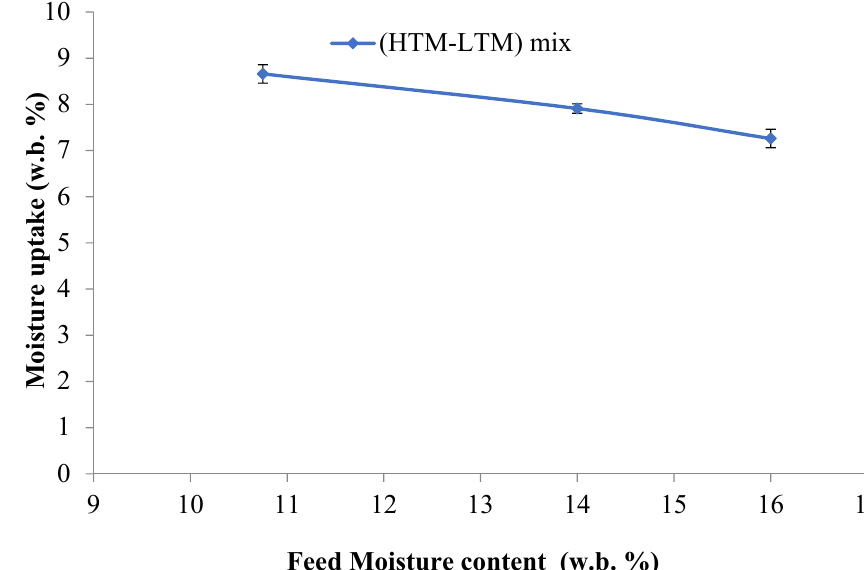
Figure 10. Moisture uptake in the briquettes at 90% relative humidity, 30 °C storage for a 24-h storage period.